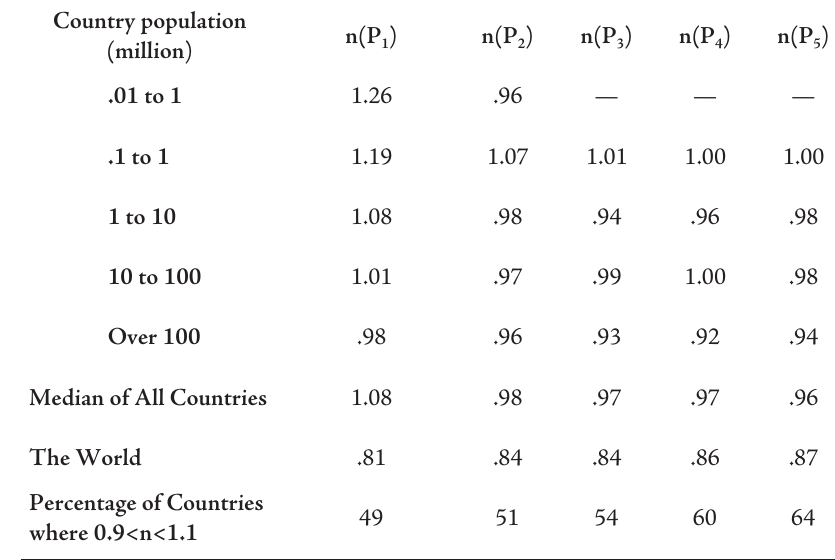
Table 1 – Median Power Constants at Various Total Populations of Countries for Largest to Fifth-largest